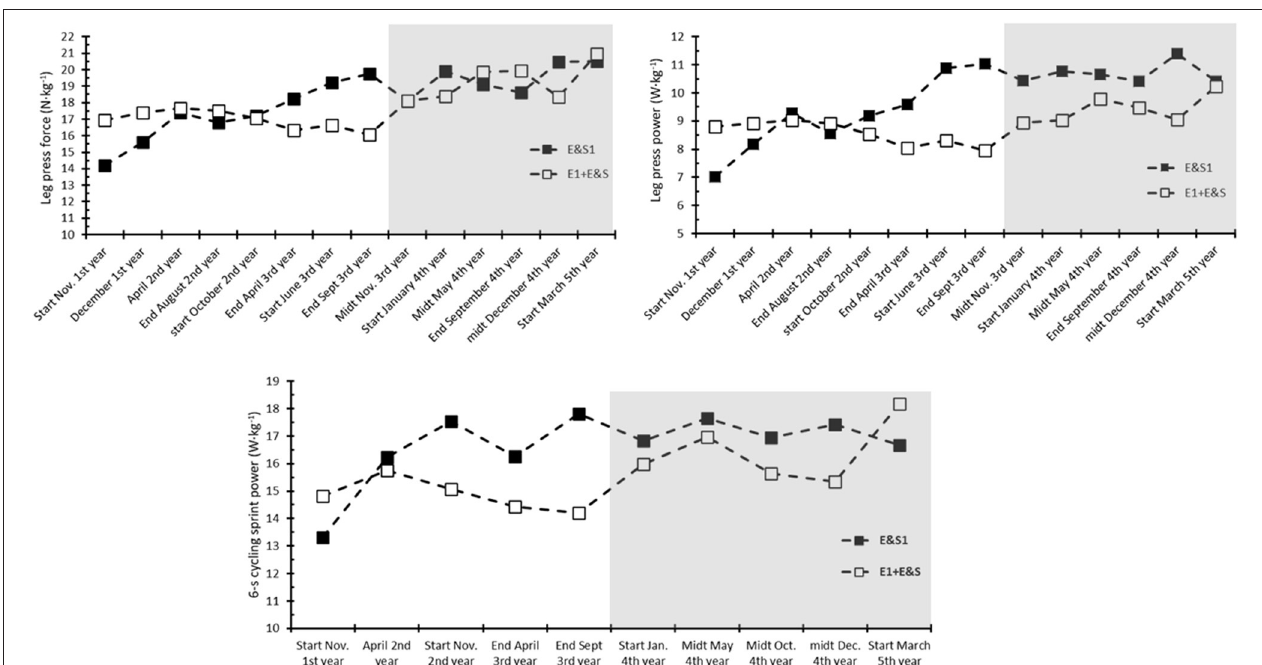
FIGURE 4 | Leg press force (upper left panel), leg press power (upper right panel), and 6-s cycling sprint mean power (lower panel) of the cyclist who performed heavy strength training during both the first and the second parts ( EandS1 ) and the cyclist who started with heavy strength training in the preparatory period after the first part ( E1 + EandS ; gray area indicates the strength training period for E1 + EandS ). Data start with the first test during the first part and conclude with the last test during the second part, altogether lasting for 3.5 years.